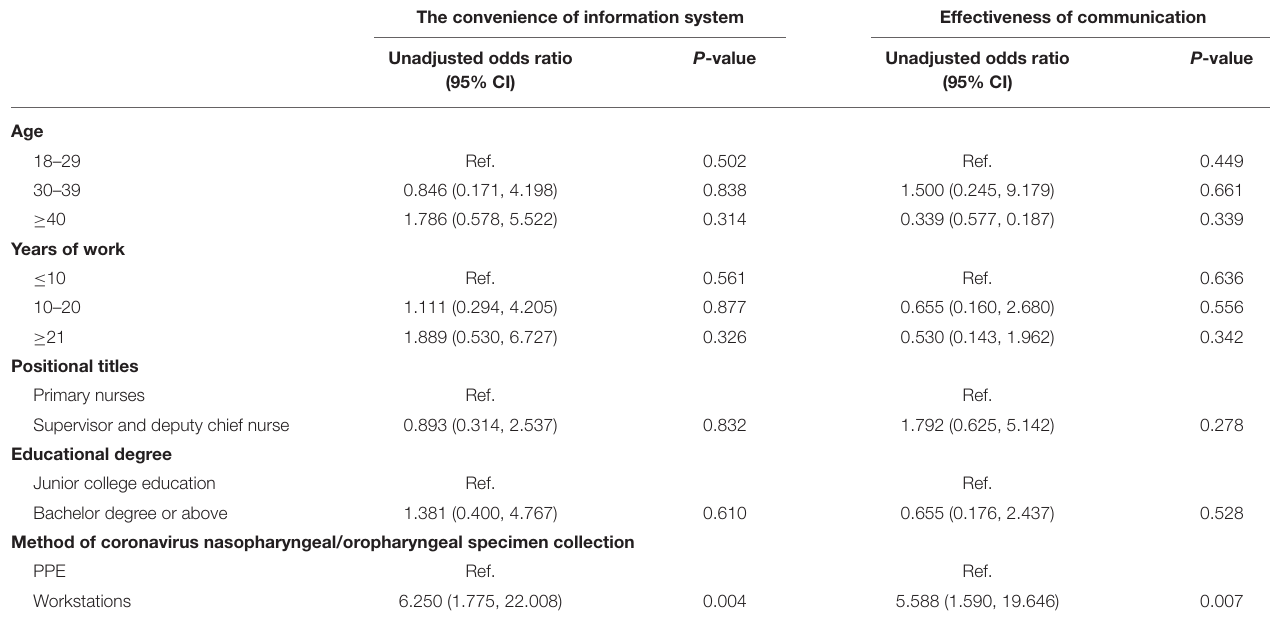
TABLE 3 | Bivariate and multivariate analysis of the convenience of information system and effectiveness of